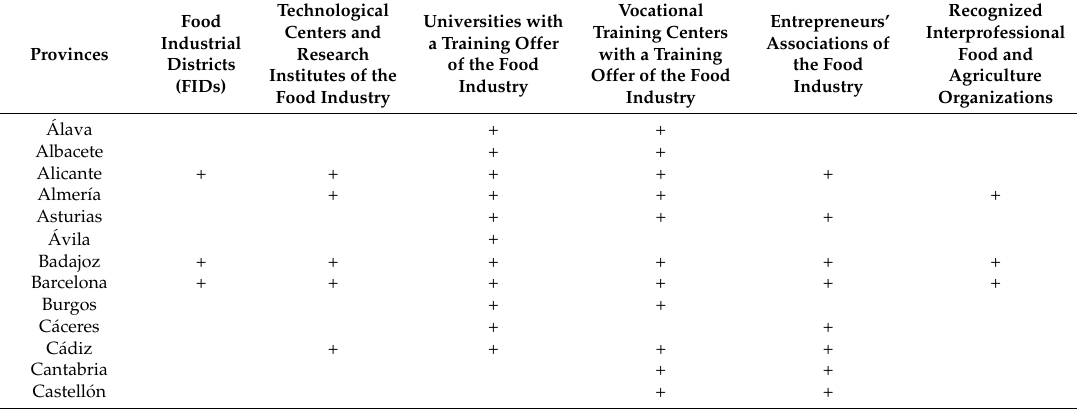
Table 1. Food industrial districts and institutions by provinces,